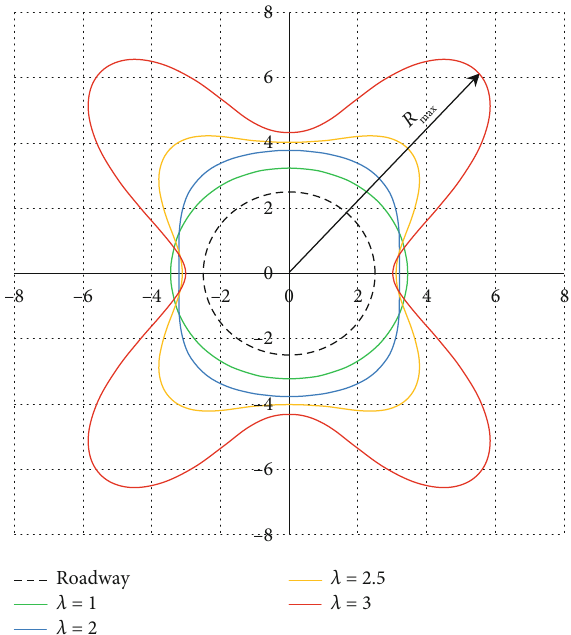
Figure 2: Characteristics of surrounding rock plastic zone under di ff erent lateral pressure coe ffi cient: P MPa , and φ = 25 ° .